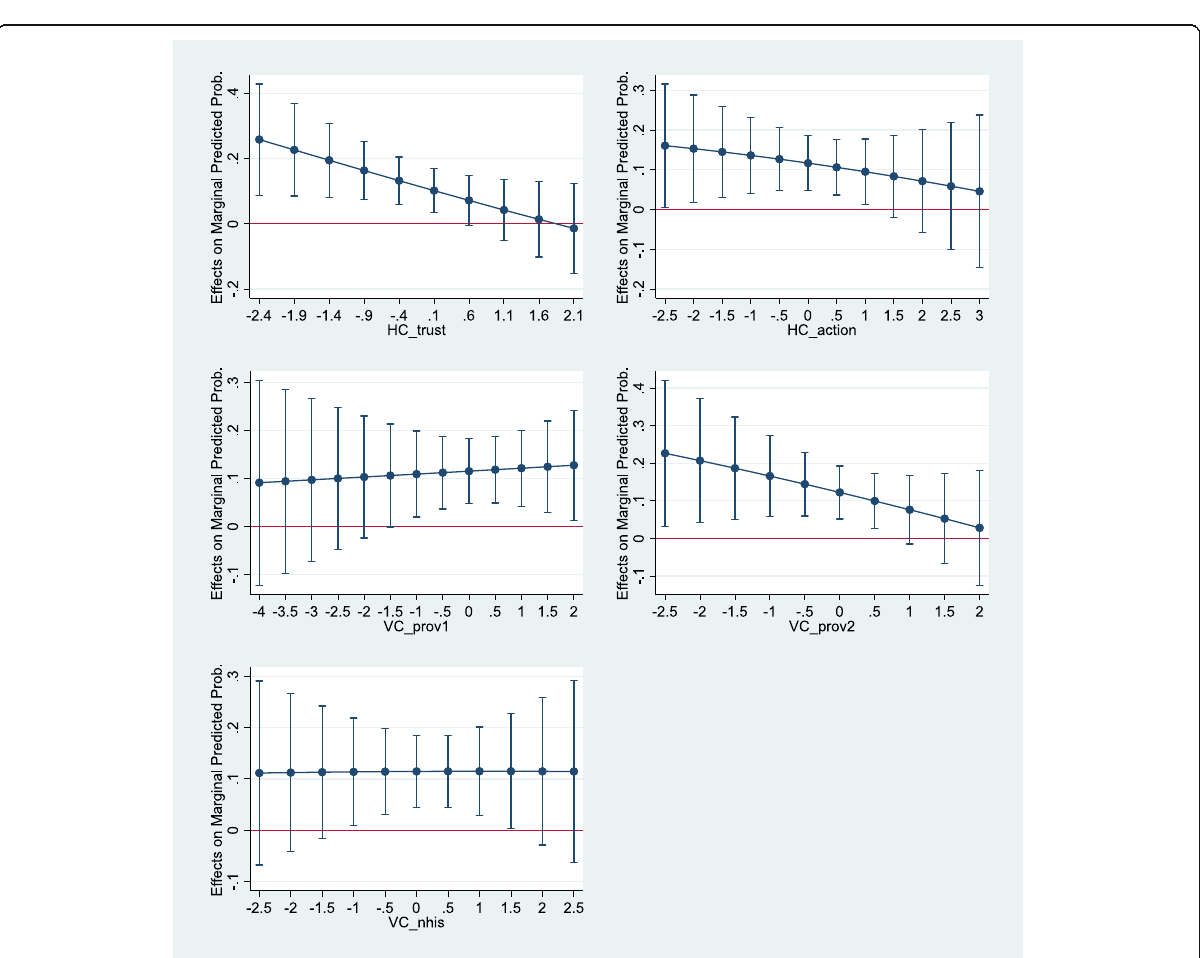
Fig. 5 The marginal effects of the interventions on enrolment by initial social capital level. Note: Marginal effects are based on models in Additional file 1: Table C.3 containing interaction